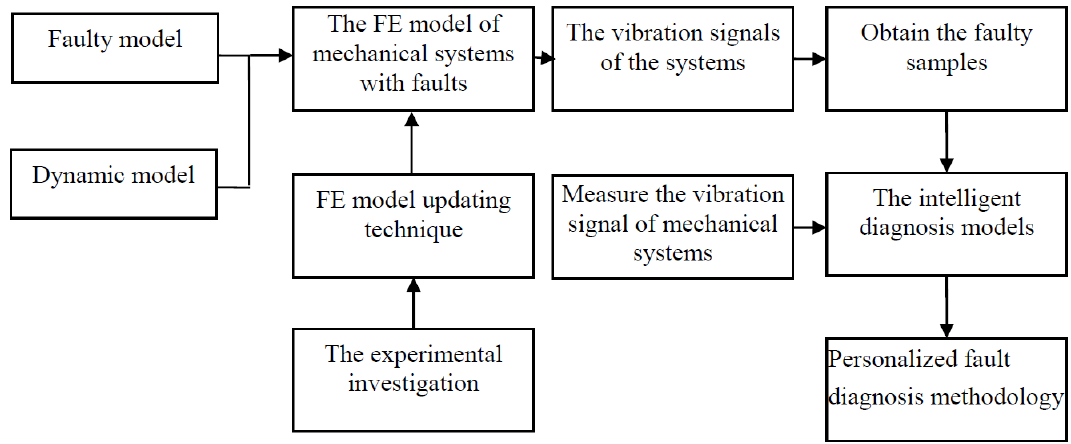
Figure 1. The fundamental procedure of the personalized diagnosis methodology.